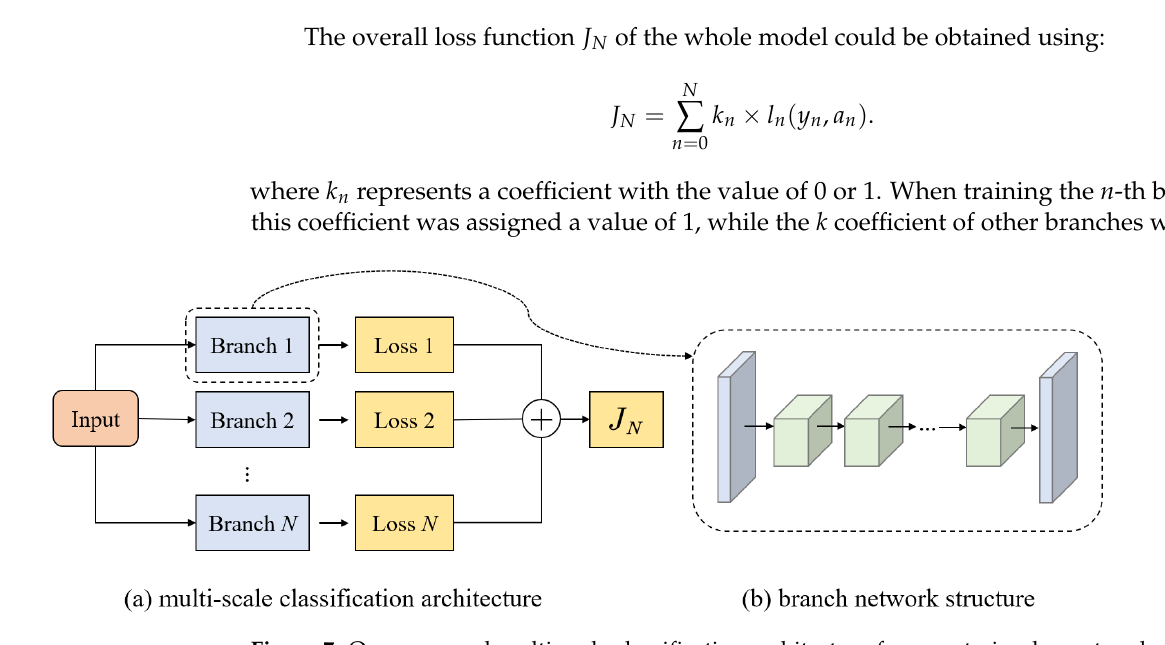
Figure 7. Our proposed multi-scale classification architecture for easy-to-implement and efficient pollen classification: ( a ) the multi-scale classification architecture, which combined several branch networks (the multi-scale architecture included N branches and the loss function of each branch was combined for training); ( b ) the branch network structure, in which each branch separately trained the backbone network according to the resolution